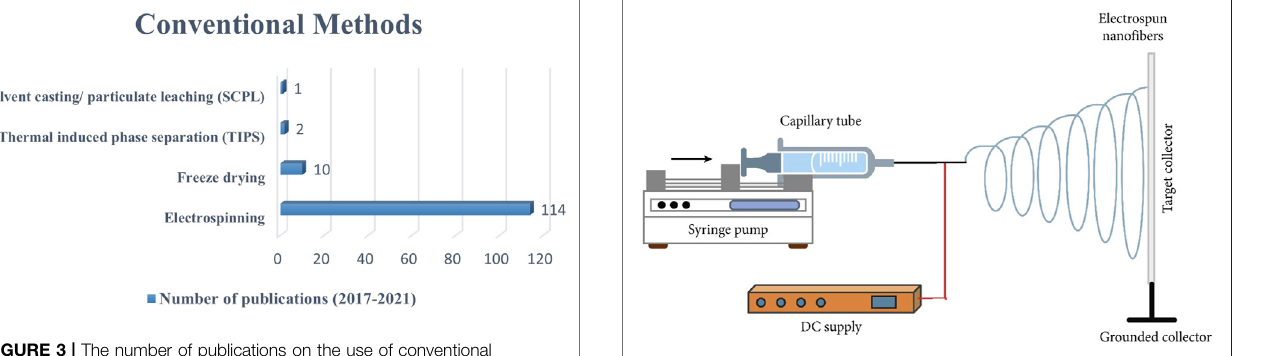
FIGURE 5 | Schematic illustration of the electrospinning set-up. Image wasadaptedfromEltometal.(2019)undertheCreativeCommonsAttribution